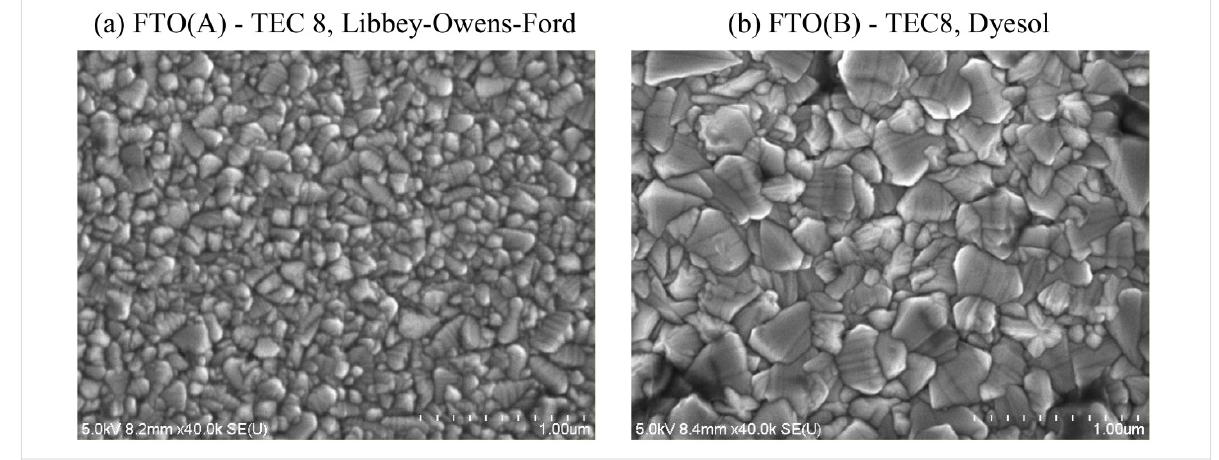
Figure 5: Top view SEM images of FTO glass substrates, (a) FTO(A) and (b) FTO(B).